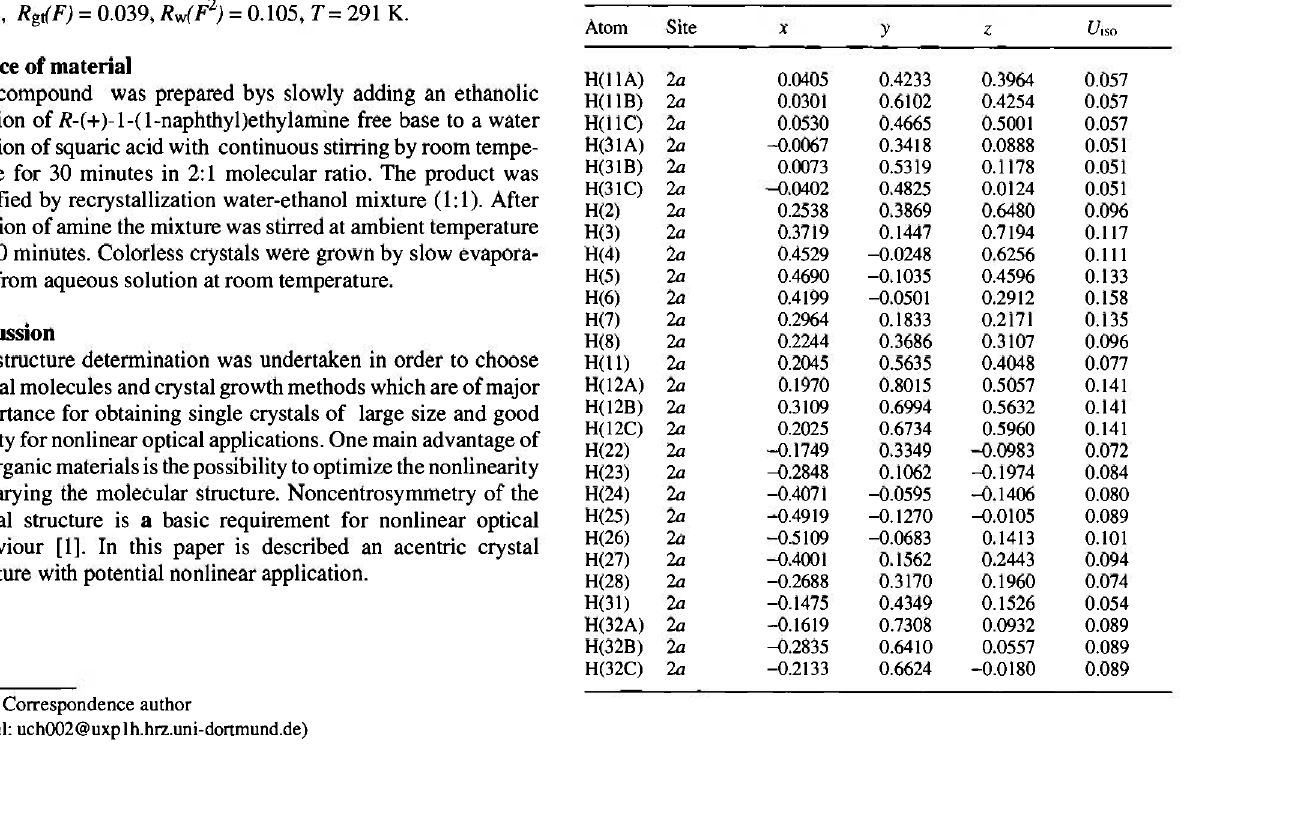
Table 2. Atomic coordinates and displacement parameters (in Ä 2